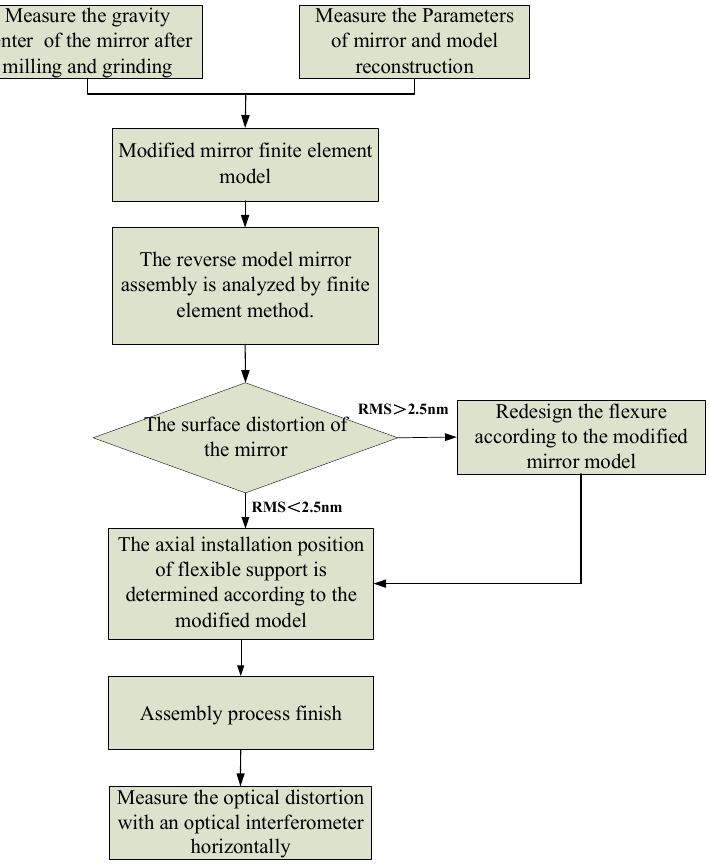
Figure 9. Flowchart of the adjustable flexure assembly process and the detection process. The dimensions that need to be measured during the reverse modeling include: the thickness of the mirror, the outline dimension, the size of the ribs and the size of the back flange. According to the characteristics of structural size, the adopted equipment includes laser tracker (accuracy: 15 µ m + 6 µ m/m), ultrasonic thickness gauge (accuracy: 0.01 mm), measuring tape, depth gauge, vernier caliper and other equipment. The detailed parameter measurement status is shown in Figure 10: Firstly, the mirror is placed on the marble platform with the front panel upward, as shown in Figure 10a. The central thickness of the mirror is measured by laser tracker. The central thickness of the mirror refers to the thickness of the geometric center of the concave mirror from the back of the mirror. The specific measurement method is to measure the overall dimension of the mirror through the laser tracker, and then calculate the geometric position coordinates of the mirror. The laser tracker establishes the relationship between the marble platform surface and the geometric center of the mirror to calculate the thickness of the mirror center. Secondly, the position of the lightweight rib is marked on the front panel of the mirror. Four points are selected in each triangle lightweight hole on the front panel of the mirror, and the thickness of each marked point is measured by ultrasonic thickness meter. The average of the four points is taken as the panel thickness in each lightweight hole. The thickness of each lightweight rib and the width of back plate are measured by caliper; Use vernier caliper to measure the thickness of back plate. The measurement results of each parameter show that the machining deviation of each parameter is within the tolerance range shown in Table